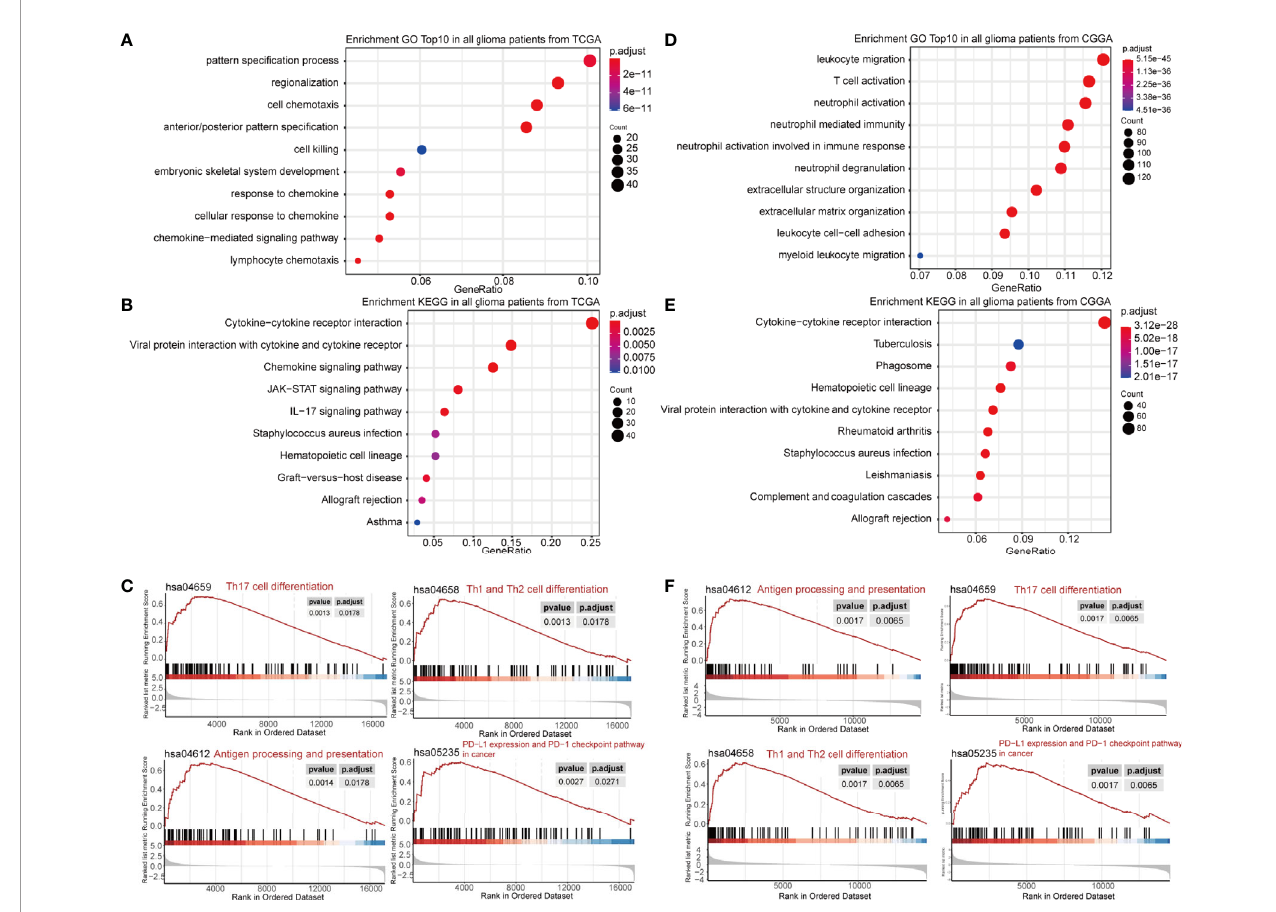
FIGURE 3 | Functional annotation of upregulated DEGs between the high- and low-GASC groups from all glioma population. (A, B) GO analysis (A) and KEGG pathway analysis (B) of up-regulated DEGs from TCGA data. (C) GSEA analysis of genes from TCGA data. (D, E) GO analysis (D) and KEGG pathway analysis (E) of up-regulated DEGs from CGGA data. (F) GSEA analysis of genes from CGGA